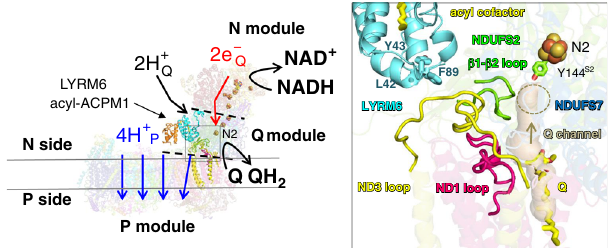
Fig. 1 Conserved loop cluster of mitochondrial complex I formed by central subunits ND1, ND3, and NDUFS2. Architecture of mitochondrial complex I from Y. lipolytica (PDB 6RFR). Cofactors of the central subunits (FMN and Fe-S clusters) and a bound Q molecule (Q) in the access pathway are highlighted (electron transfer pathway to Q is indicated by red arrow). The peripheral arm is composed of the N module (NADH oxidation) and the Q module (Q reduction). The membrane arm represents the proton pumping (P) module with the pathways (blue arrows) for pumped protons H + P . The reduction of Q requires electrons from terminal Fe-S cluster N2 and two protons for Q redox chemistry (H + Q , black arrow) from the negative side of the membrane. Interfaces between modules are indicated by black dashed lines. The accessory LYRM6/ACPM1 (NDUFA6/ NDUFAB1- α ) heterodimer at the Q/P module interface is highlighted. Subunits ND1, ND3, and NDUFS2 form an important part of the Q/P module interface region. Inset, the TMH1-2 ND3 loop of subunit ND3 (yellow) is located at the Q/P module interface and interacts with the N- terminal β -sheet S2 of subunit NDUFS2 (green). The TMH5-6 ND1 loop (hot pink), THM1-2 ND3 loop (yellow) and β 1- β 2 S2 loop (green) form a conserved loop cluster. The tunnel for access of Q to the Q reduction site is shown in transparent brown color and the Q reduction site close to Y144 S2 is highlighted in brown dashed lines. Residues L42 LYRM6 , Y43 LYRM6 , F89 LYRM6 , Y144 S2 , the Q molecule and acyl cofactor are shown in stick representation,